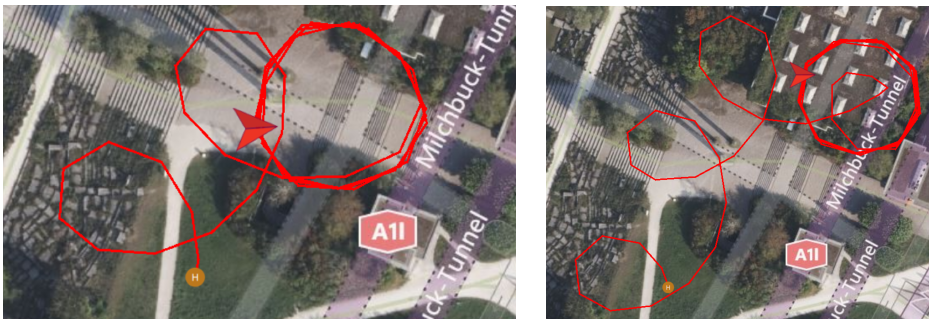
Figure 10. The cruising contour of drones. Left graph shows the path of 3-targets cruising simulation, the right graph is the contour of 4-targets cruising